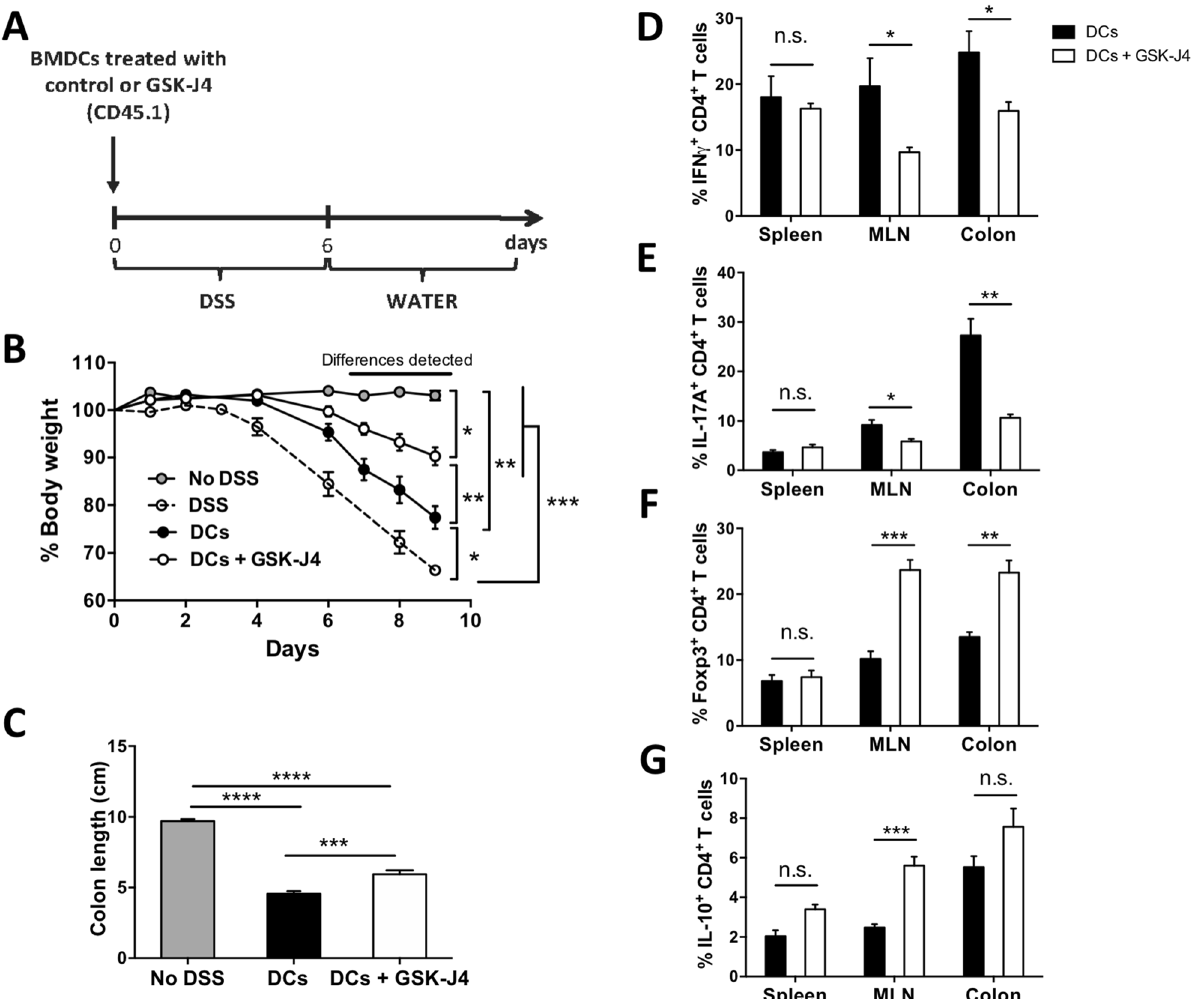
Figure 2. DCs treated ex vivo with GSK-J4 ameliorate DSS-induced acute colitis. Bone marrow-derived DCs obtained from Cd45.1 +/+ Cd45.2 −/− mice were treated with vehicle (control) or with 25 nM GSK-J4 for 18 h, and then 3 × 10 6 DCs/mice were i.v. transferred into wild-type Cd45.1 −/− Cd45.2 +/+ recipient mice. Colitis was immediately induced in recipient mice by treatment with 1.5% DSS for 6 days. ( A ) Scheme illustrating the experimental design. ( B ) Bodyweight change respect to the initial weight was calculated throughout the time- course of the disease. Values represent mean ± SEM from 4 to 10 mice per group. ( C ) Colon length of each experimental group was evaluated on day 9 after colitis induction. Values represent mean ± SEM from 8 to 10 mice per group. ( B , C ) As a control, a group of mice did not receive DSS treatment. ( D – G ) At the peak of disease severity (day 9), mice were sacrificed and mononuclear cells were isolated from spleen, MLN and colon followed by ex vivo stimulation with PMA/ionomycin in the presence of brefeldin A. Intracellular cytokine staining analyses were carried out by flow cytometry. Frequency of ( D ) IFNγ + , ( E ) IL-17A + , ( F ) Foxp3 + , and ( G ) IL-10 + cells from CD4 + T-cells isolated from spleen, MLN and colon. Values represent mean ± SEM from 5 mice per group. * p < 0.05; ** p < 0.01; *** p < 0.001 as determined by one-way ANOVA followed by Tukey’s post-hoc test ( B , C ) or two-way ANOVA followed by Bonferroni’s post-hoc test ( D – G ). n.s., not significant differences were